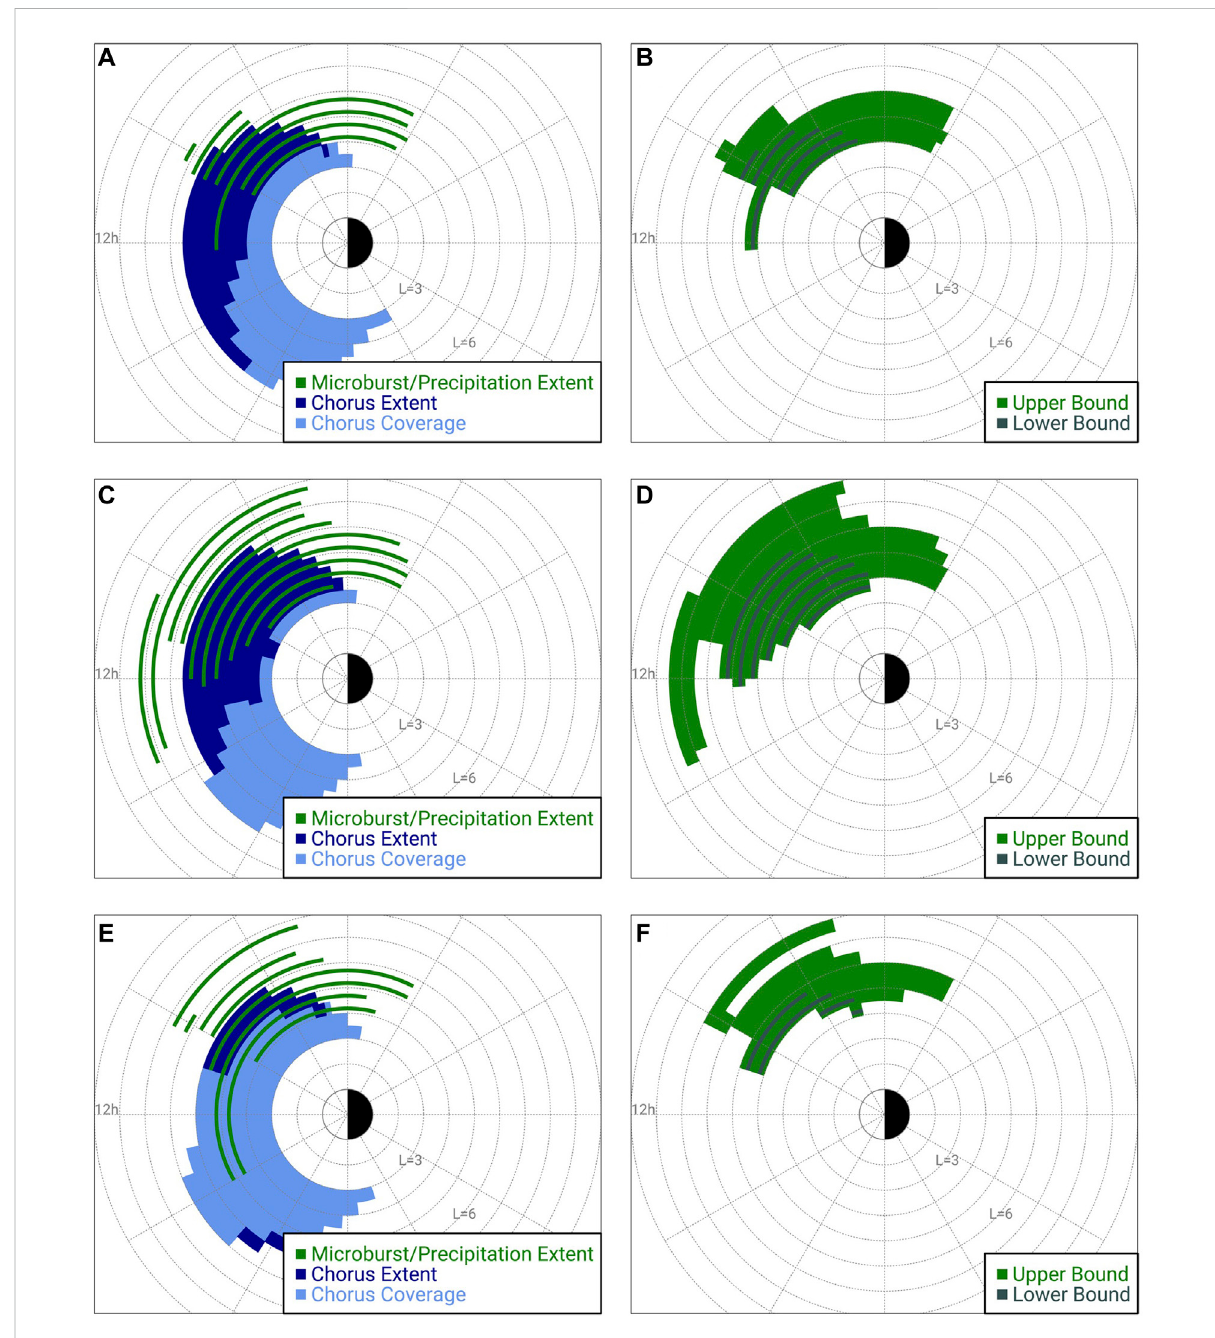
FIGURE 3 From Elliott et al. (2022) showing chorus observations from RBSP, Arase, and ground-based VLF stations, and microburst precipitation from FIREBIRD, AeroCube-6, and POES. (A,C,E) Overview of three periods of persistent chorus and microburst precipitation observations. Green bars represent microburst precipitation extent between 4 and 14 MLT. Dark blue bars show the chorus extent. Light blue bars show the chorus coverage. (B,D,F) Upper (green) and lower (gray) bounds on the size of the microburst-producing chorus region. Green bars (upper bound, in B,D,F) includeregionswherechorusandmicroburstprecipitationareobservedandregionswhereonlymicroburstsareobservedbutnochoruswavesdue to lack of